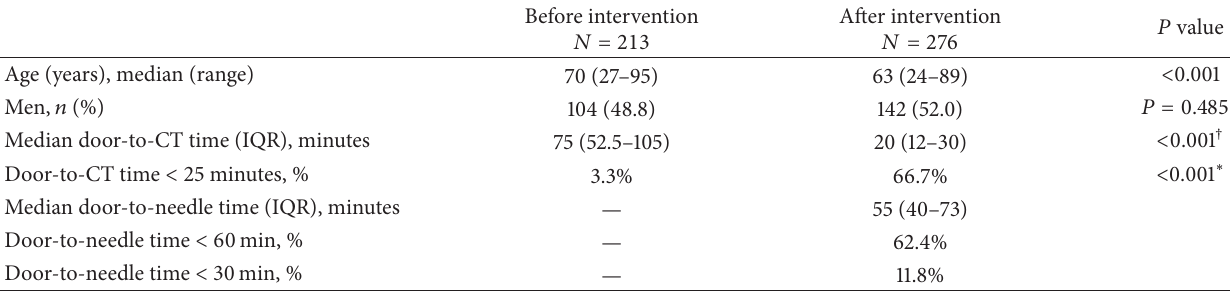
Table 1: Demographic parameters and outcome